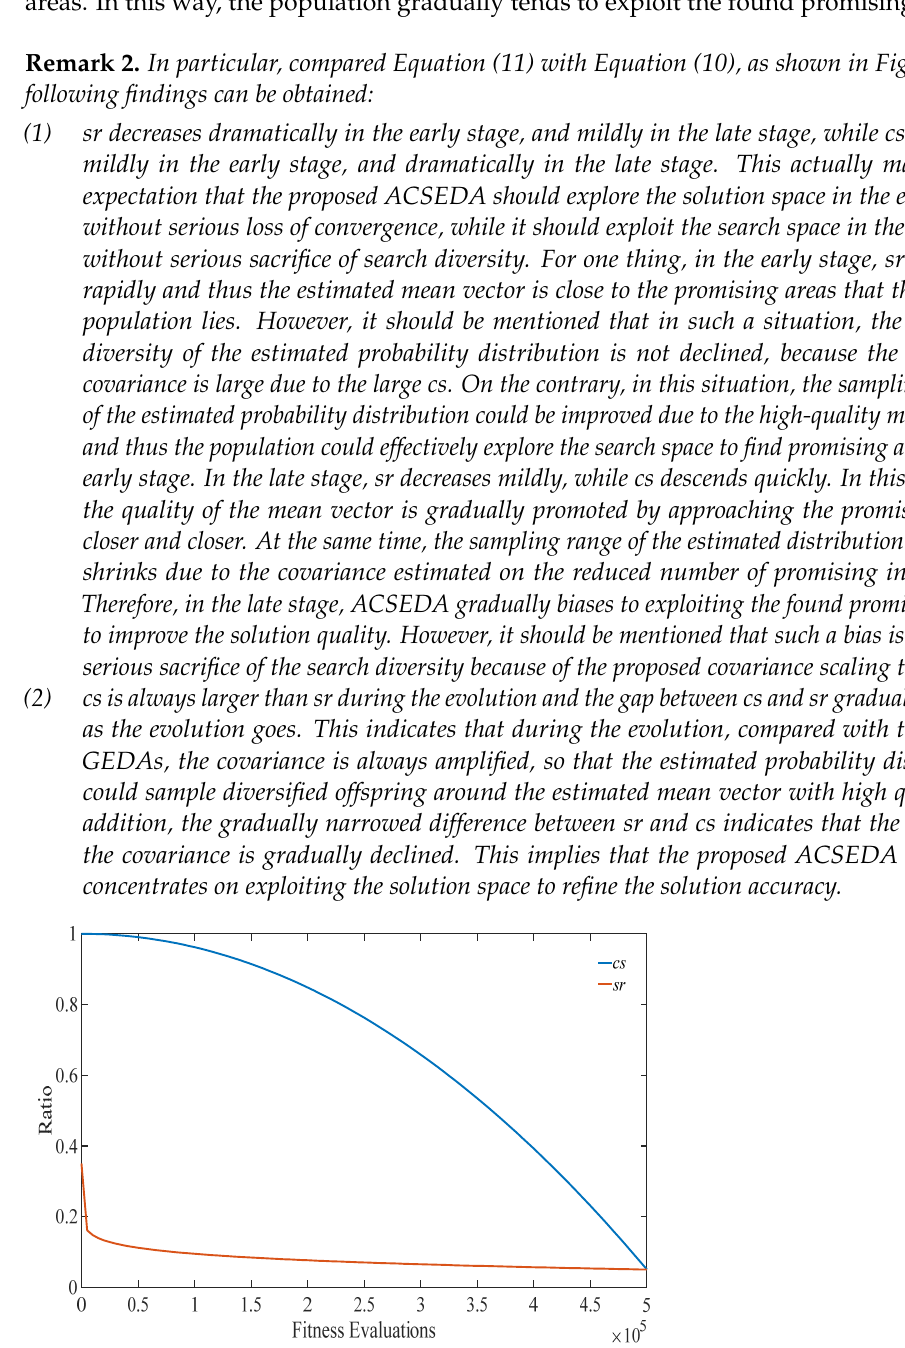
Figure 2. The change curves of cs and sr with the proposed two adaptive strategies.